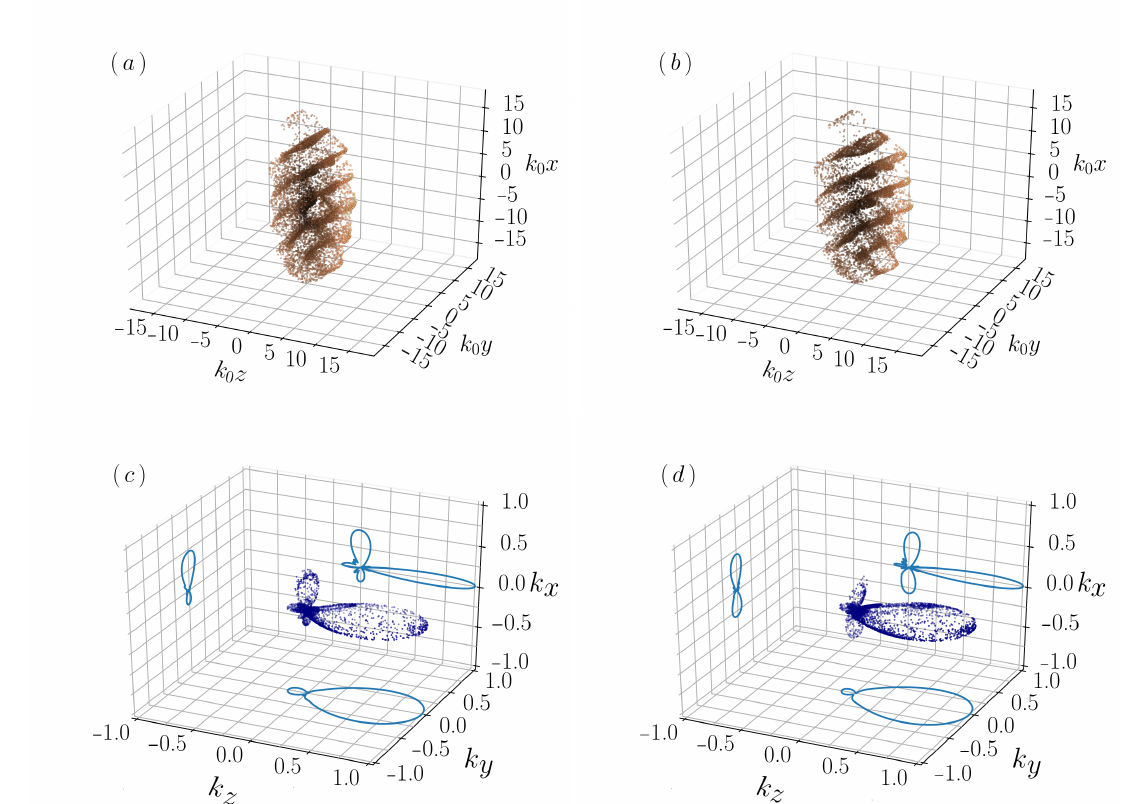
Figure 5. Collective scattering and pattern formation from an ellipsoidal 3D atomic cloud irradiated with a pump field propagating perpendicular to its major axis and linearly polarized along the y axis: ( a ) Shows the atomic density distribution with N = 10 4 at the time instant t = 0.188 ω − 1 r , with an initial random distribution. ( b ) Depicts the density grating formation due to collective scattering at t = 0.222 ω − 1 r . The corresponding bunching factors | M ( k , t ) | for both time instants are displayed in ( c ) for t = 0.188 ω − 1 r and in ( d ) for t = 0.222 ω − 1 r